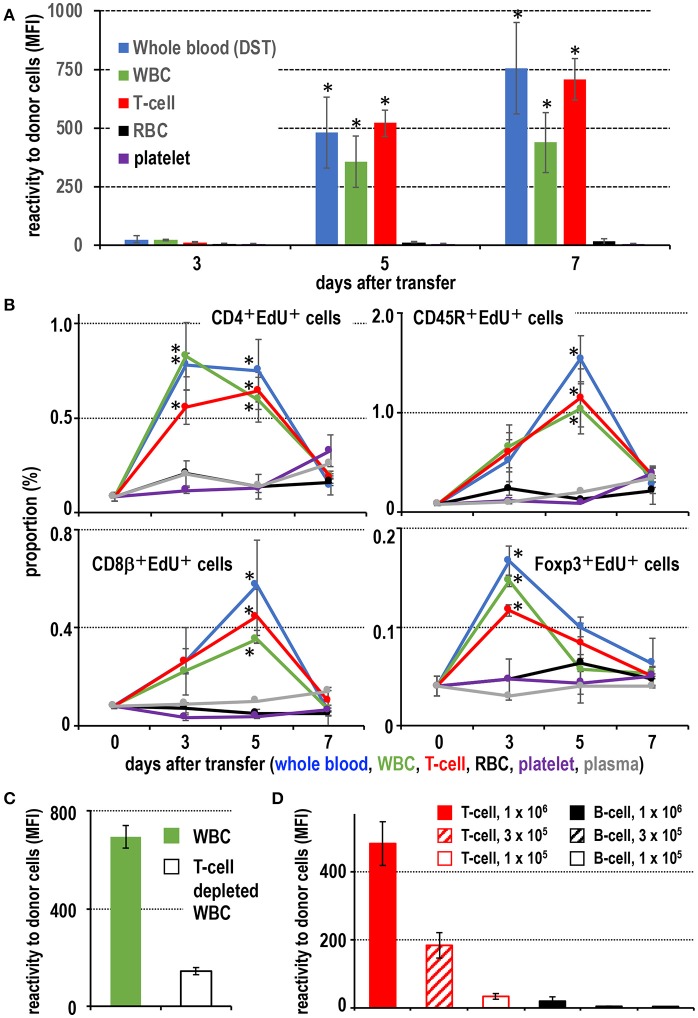
Screening of effective blood components for the donor-specific transfusion (DST) response. (A) Production of DST antibodies in recipient blood after donor blood component injection. In the white blood cell (WBC) and T cell injected groups, DST antibodies were detected after 5 days (mean ± SD, n = 3 rats each, *P < 0.05). (B) The time kinetic changes in each proliferating cell type as a proportion of total splenocytes. Two-color FCM analysis of recipient splenic lymphocytes after donor blood component injection for proliferating cells (EdU+) and CD4+ T cells, CD8β+ T cells, CD45R+ B cells, or regulatory T cells (Foxp3+). The proliferation of CD4+ T cells and regulatory T cells peaked 3 days after treatment, whereas B cells and CD8β+ T cells peaked at 5 days. These results were similar to the DST group that received whole blood (mean ± SD, n = 3 rats each, *P < 0.05). (C) With T cell depletion of WBCs, the DST antibody production was suppressed at 7 days. (D) Dose-dependent response following injection of isolated T cells or B cells. T cells induced much higher DST antibody production than B cells (mean ± SD, n = 3 rats each, *P < 0.05). MFI, mean fluorescent intensity.